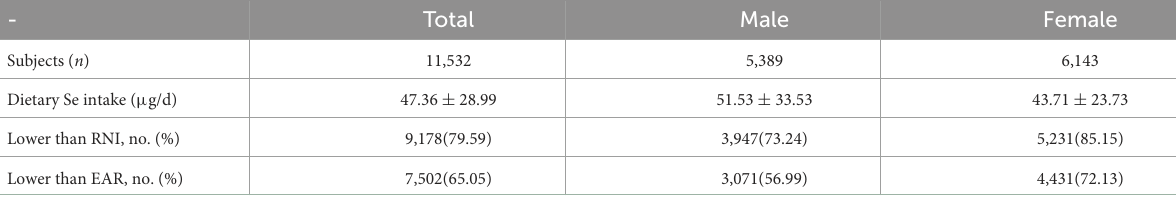
TABLE 1 Selenium intake among Chinese adults. - Total Male Subjects ( n ) Dietary Se intake ( µ g/d) Lower than RNI, no. (%) Lower than EAR, no.